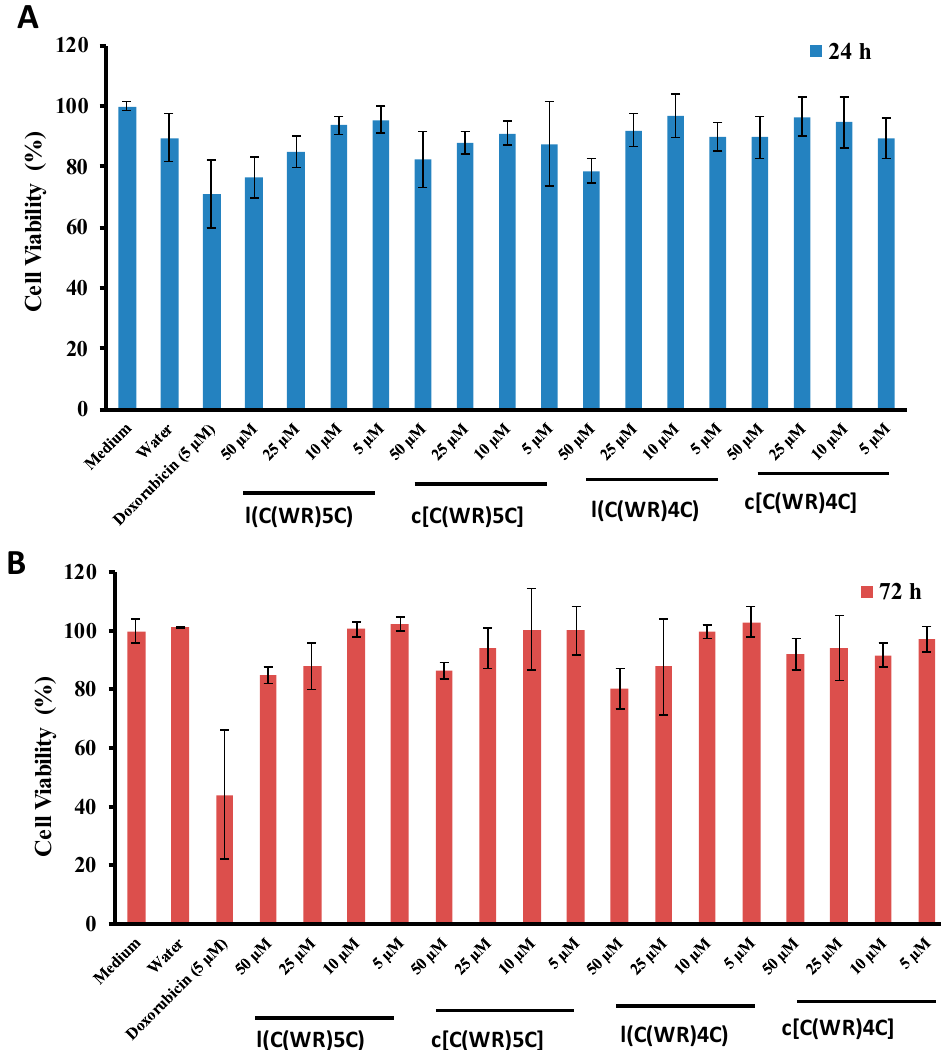
Figure 5. MTS assay of peptides (5–50 µM) on SKOV-3 cell lines: ( A ) 24 h incubation and ( B ) 72 h incubation ( n = 3). (Results are not statistically significant). Error bars are SD.